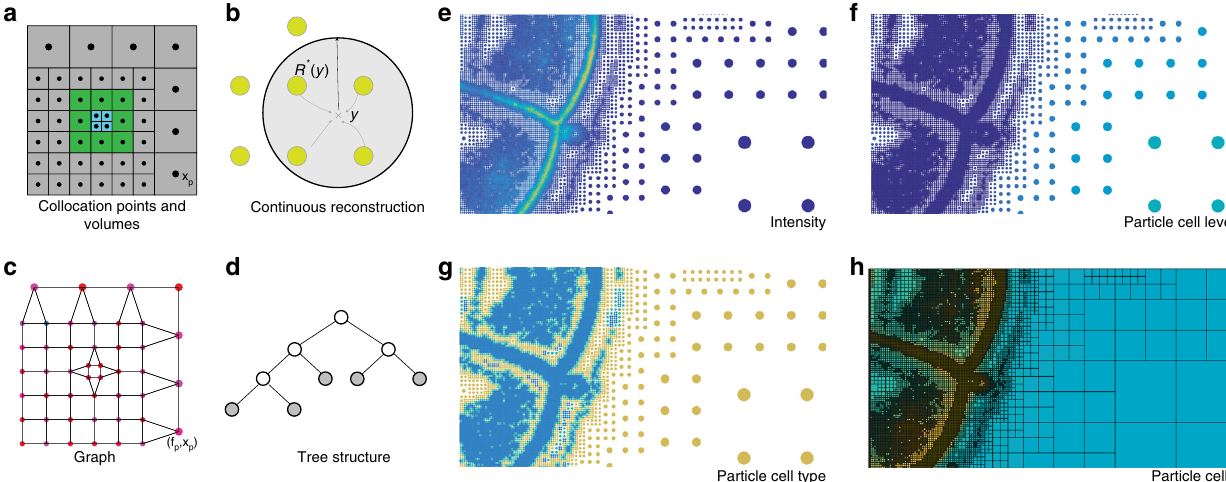
Fig. 3 Interpretations of the APR for image processing. a The APR can be interpreted as a spatial partition de fi ned by the Particle Cells or by the set of particles with positions x p . This interpretation relates to the concept of super-pixels 13 . b The APR can be interpreted as a continuous function approximation where the intensity value can be reconstructed at each location y , also between particles and pixels, relating to smooth particle function approximations 31 . c The APR can be interpreted as a graph, where the particles are vertices and edges link neighboring particles (Supplementary Note 21). This relates the APR to graphical models of pixel images 32 . d The APR can be interpreted as a pruned binary tree (quadtree in 2D, octree in 3D) with links between parent and children Particle Cells. This relates the APR to wavelet decompositions 17 , image pyramids 19 , and tree-based methods 33 . e – h While particles store local fl uorescence intensity, just like pixels ( e ), they also provide additional information that is not available on the pixels. This includes the Particle Cell level containing information about the local level of detail in the image ( f ), the Particle Cell type encoding the structure of the image ( g ), and the Particle Cell membership providing a content-adaptive disjoint partition of the image domain ( h ). (See Methods section for de fi nitions; original